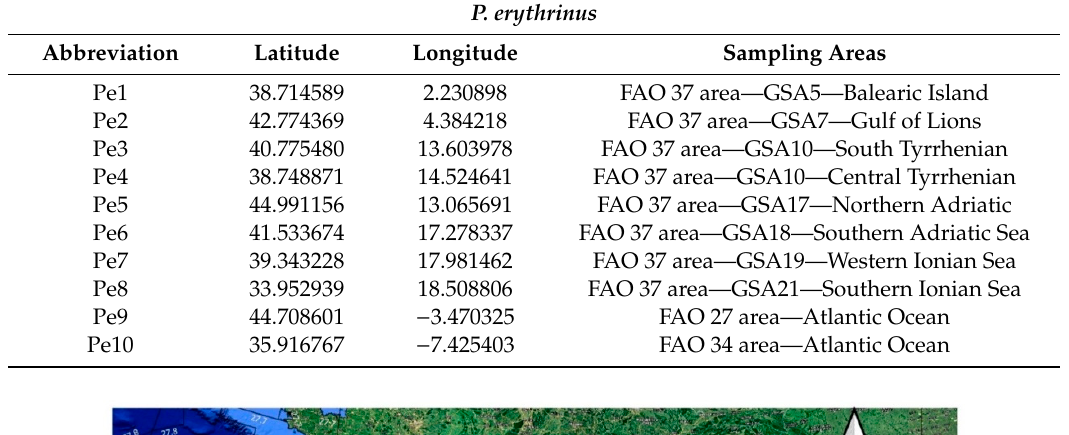
Table 1. Geographical origins of the P. erythrinus specimens sampled for this study.